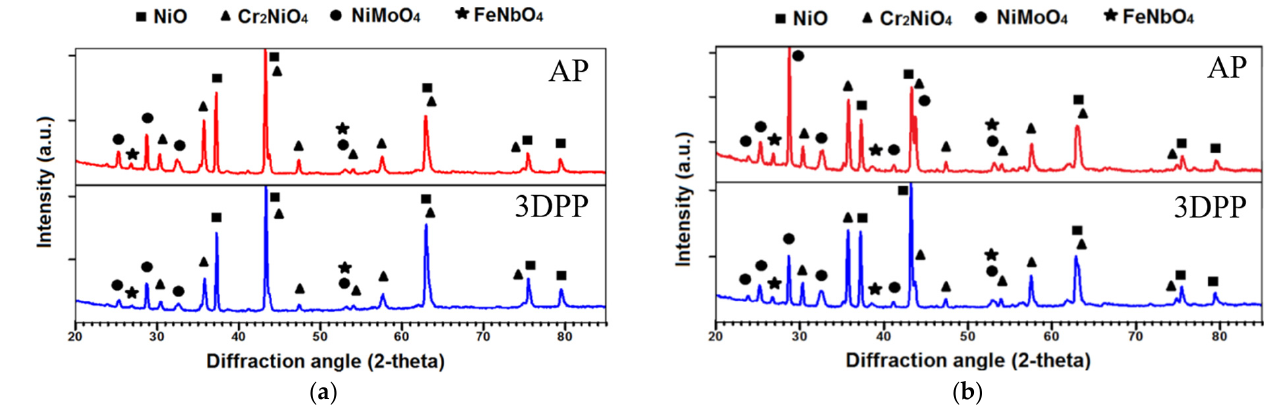
Figure 3. XRD patterns of the corrosive layer after hot corrosion at 900 °C for 96 h ( a ) and at 1000 °C for 8 h ( b ).